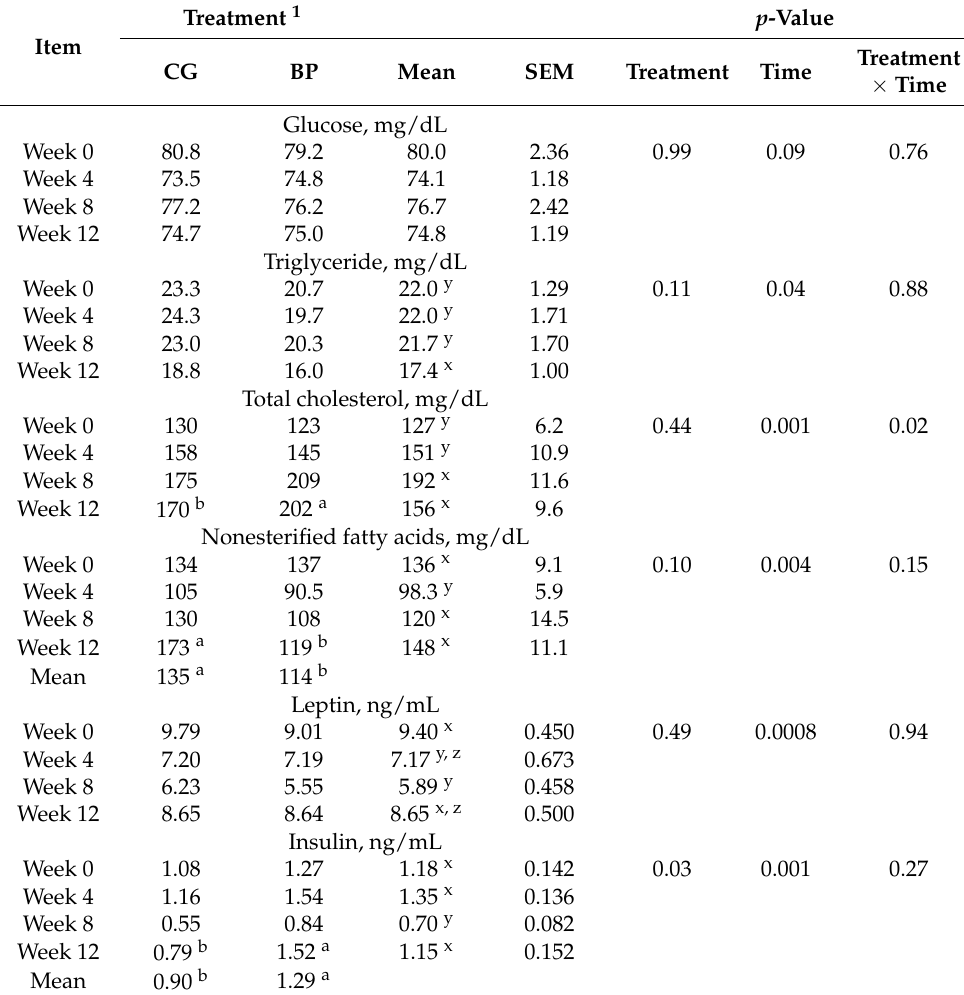
Table 4. Effects of feeding beet pulp in replacement of corn grain on blood metabolites of Korean cattle